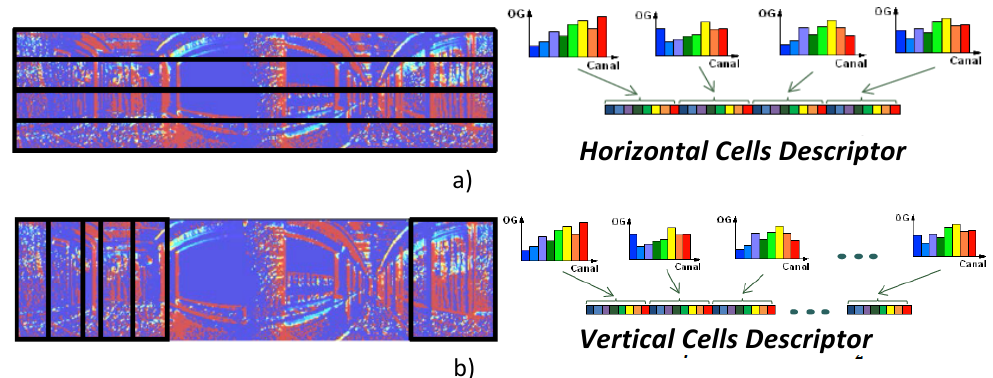
Figure 1. Approaches to build a global-appearance descriptor from a panoramic image: ( a ) with horizontal and ( b ) with overlapped vertical